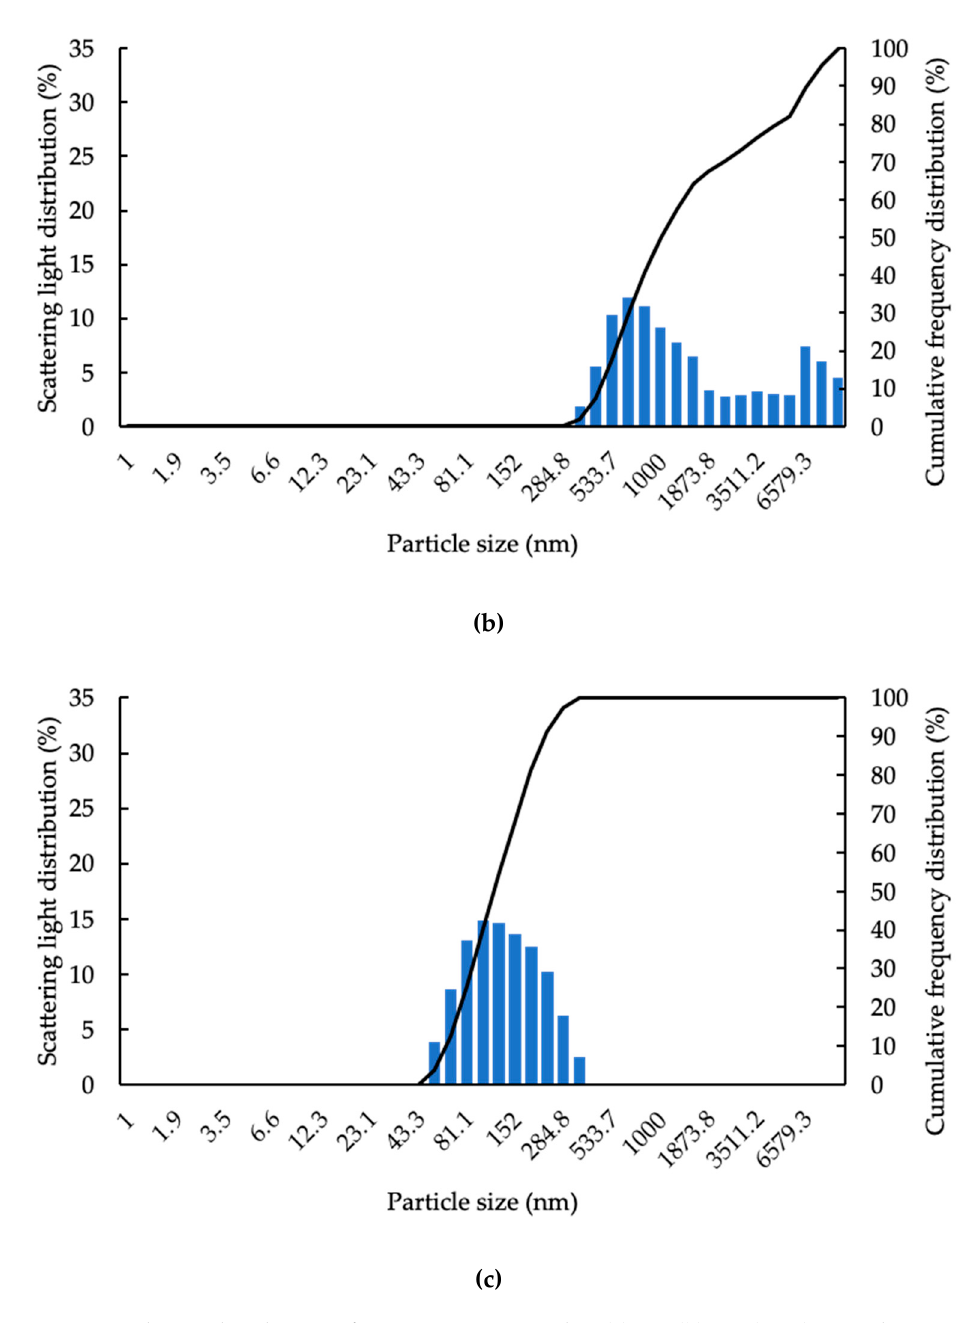
Figure 4. Particle size distribution of representative samples: ( a ) RB; ( b ) PM (1:5:1)-30 with PVP K30; ( c ) GM (1:5:1)-30 with PVP K30. Table 3. Particle sizes of samples.